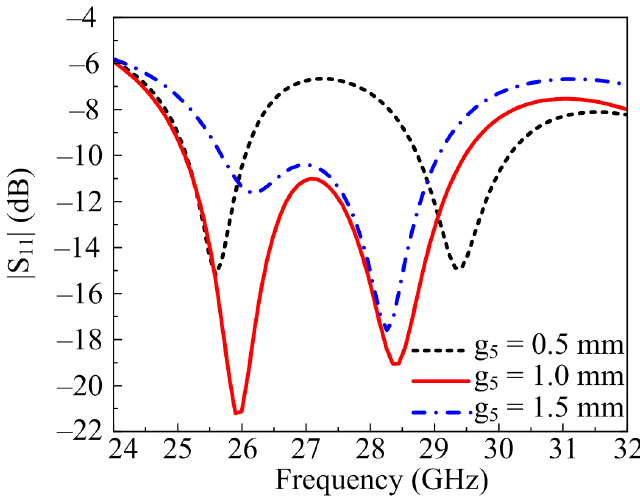
Figure 3. Parametric study of the stub width variation.